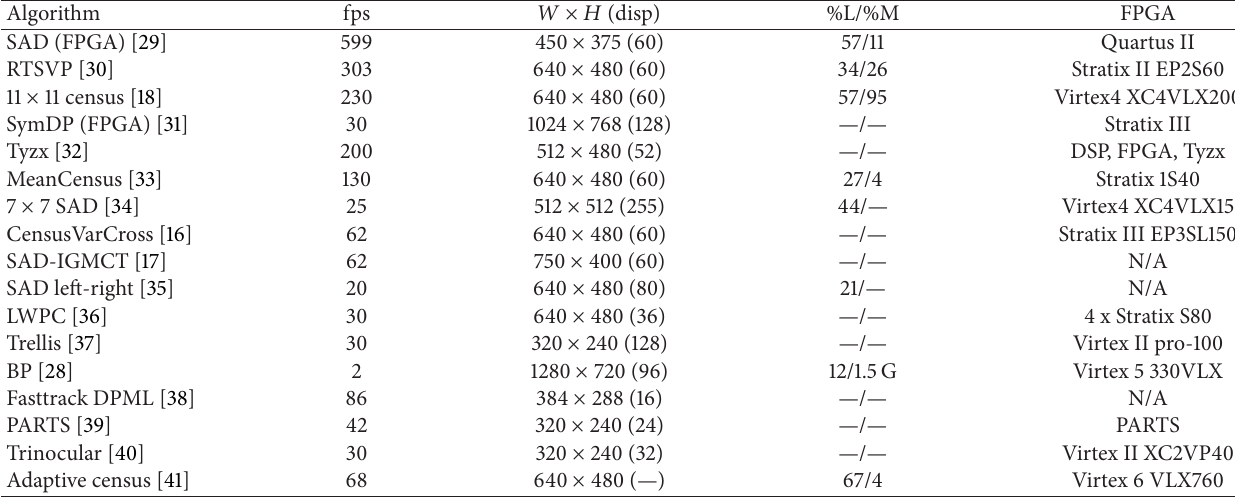
Table 1: Published FPGA implementation of stereo vision algorithms. FPGA resource usage is given, for those publications that provide it, in terms of percentage of configurable logic (%L) and percentage of memory (%M) for the specific device. The one exception is the BP implementation by P´erez et al. [28] which required a device with access to a total of 1.5 GB of